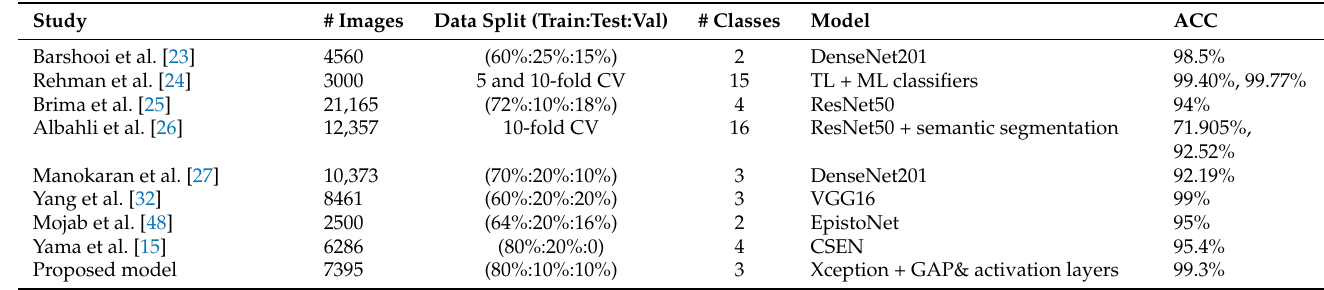
Figure 9. Confusion matrices of the pre-trained models with learning rate η = 0.1, ReLU activa- tion function, and Adam optimizer. ( a ) VGG16, ( b ) Xception, ( c ) DenseNet121, ( d ) InceptionV3, ( e ) ResNet50, and ( f ) MobilNet. Table 7. Previous works for COVID-19 classification. Here, MCSVM, CSEN, ML, TL, CV, and ACC stand for multi-class support vector machine, convolution support estimation network, machine learning, transfer learning, cross-validation, and accuracy,